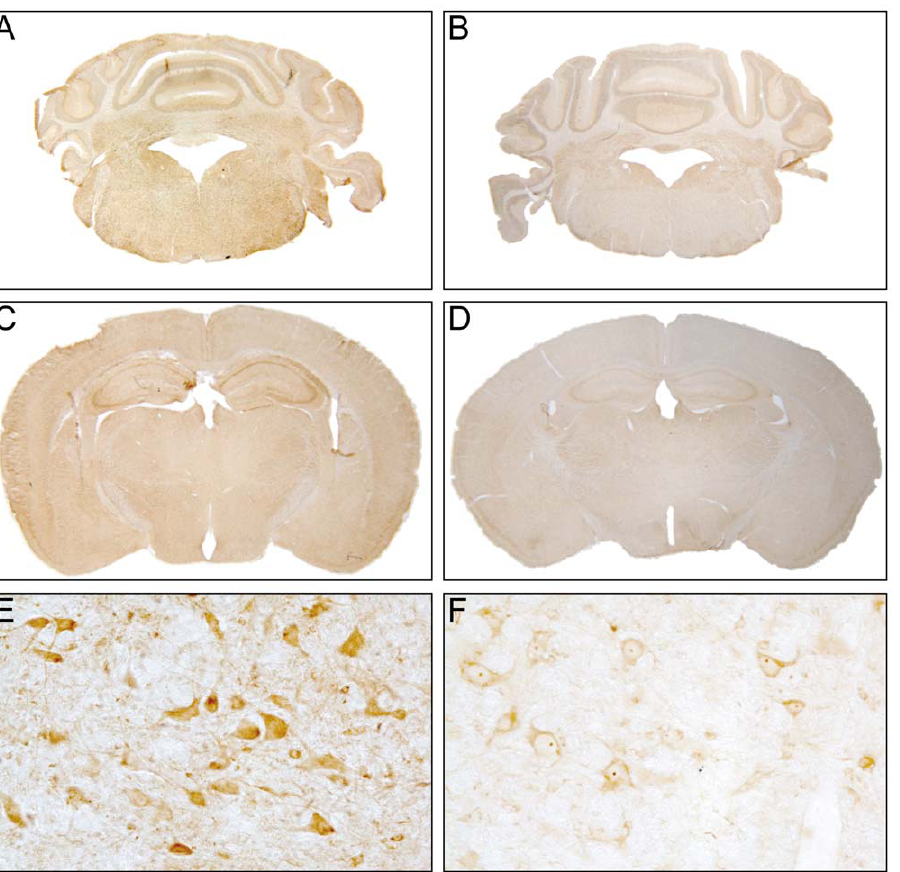
Figure 3. Representative micrographs of an animal with severe CM (A, C, E) and a non infected control animal (B, D, F). A, B, E, F: bregma -6 (cerebellum and brainstem); C, D: bregma -2 (cortex, hippocampus and thalamic nuclei). In CNT animals, brain sections showed mild labeling for Nogo-A (B, D, F). In CM animals more intense neuronal and oligodendroglial Nogo-A labeling was observed (A, C, E) especially in the brainstem (E). Magnifications: A–D: 1x, E-F: 20x.